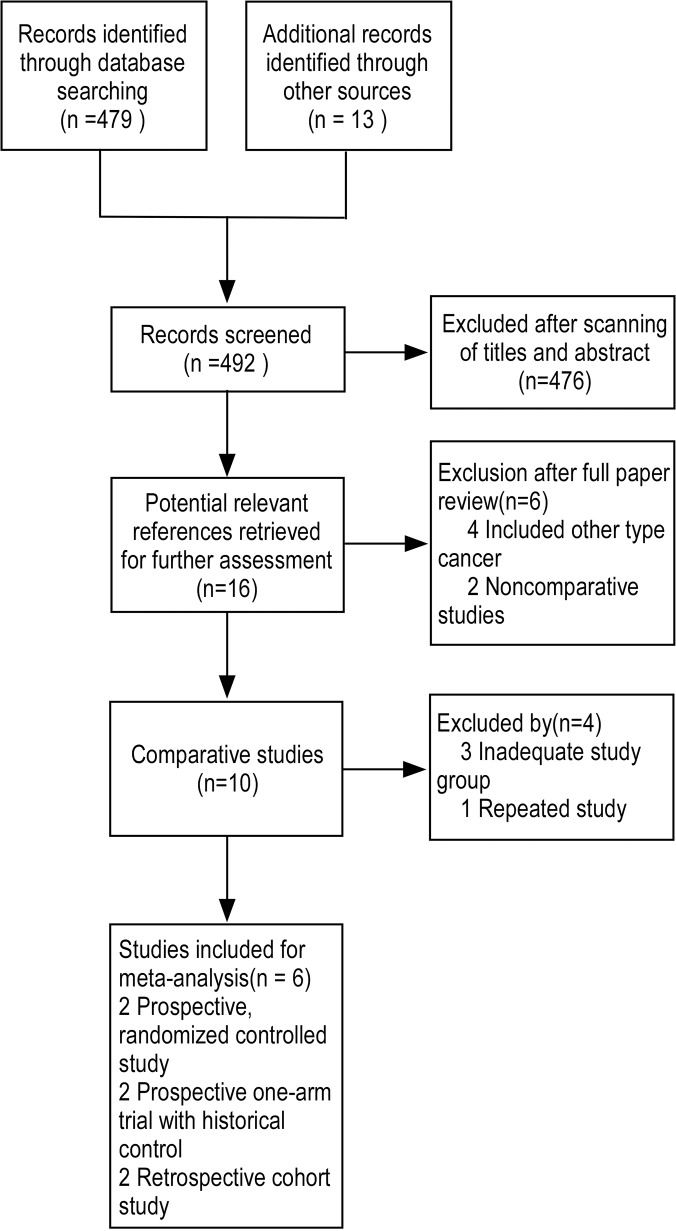
Schematic illustration of strategy to identified the subjects meeting the requirement in this study.Totally 492 records had been identified by literature searching. Based on abstracts, only 16 articles had been viewed as potential references for further assessment. After reviewing these articles in detail, only 6 articles had been selected for the meta-analysis.